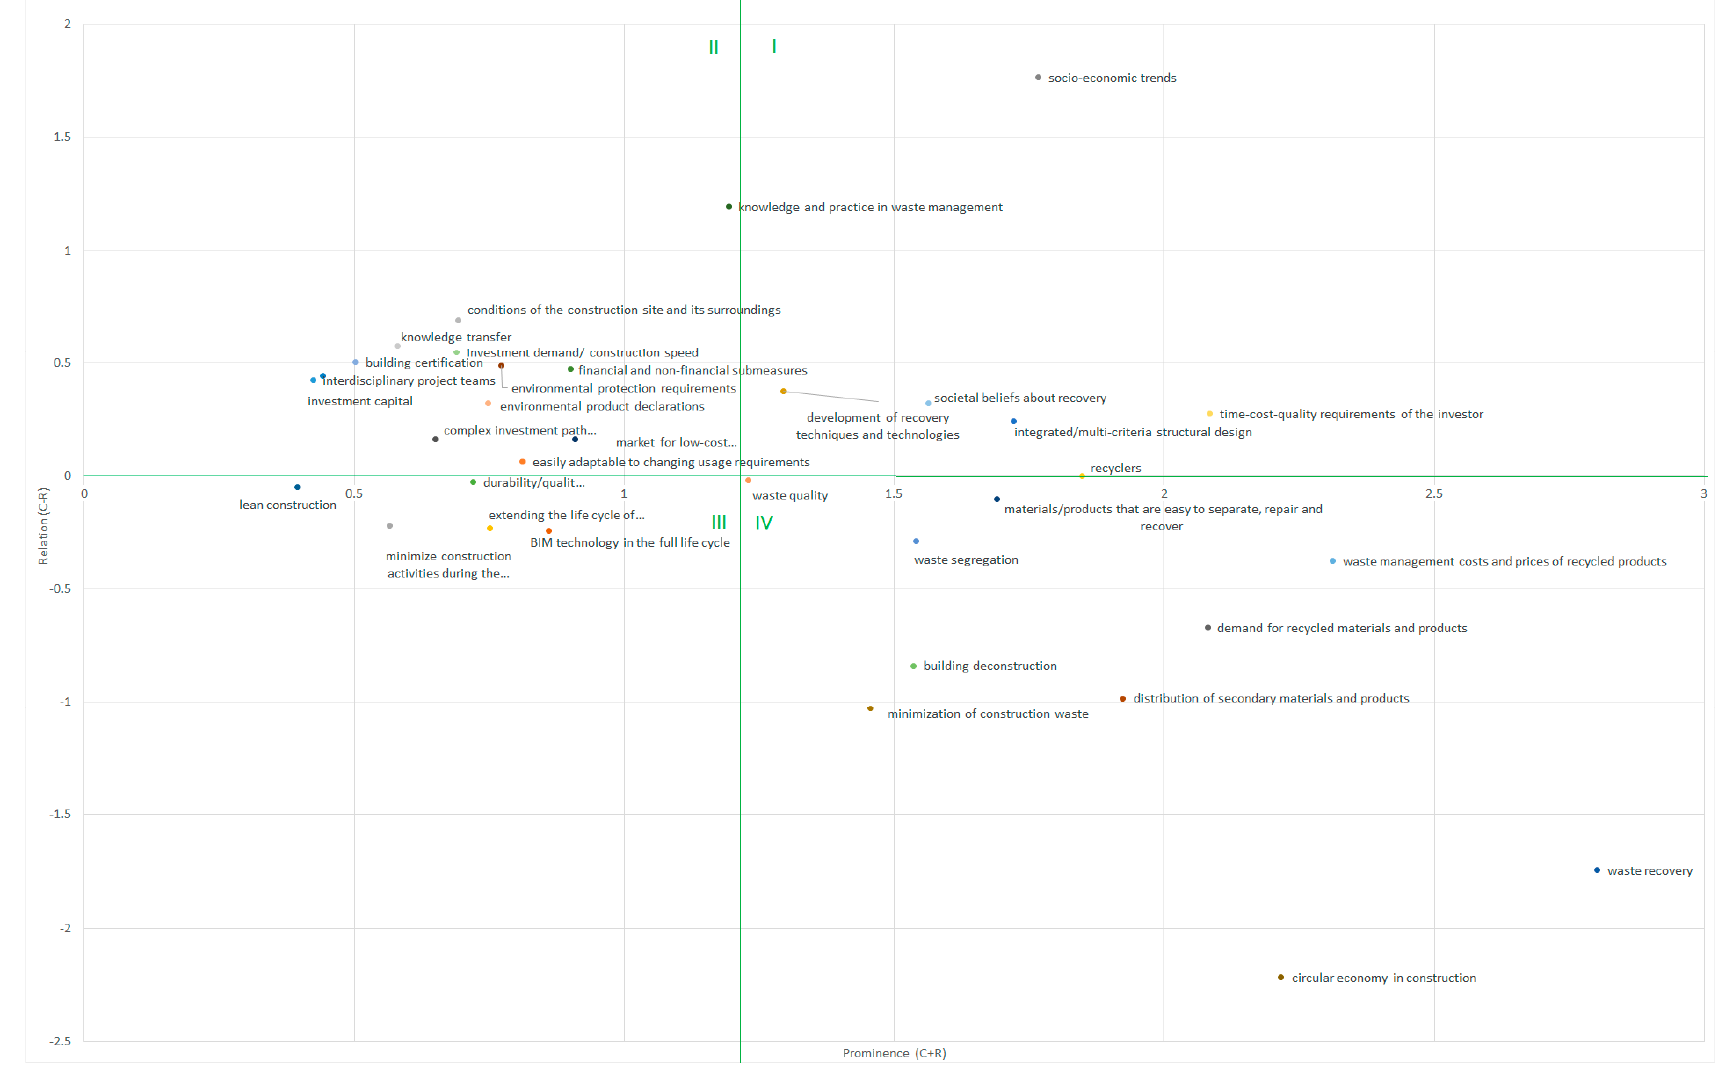
Figure 5. Relationship factor and prominence diagram.